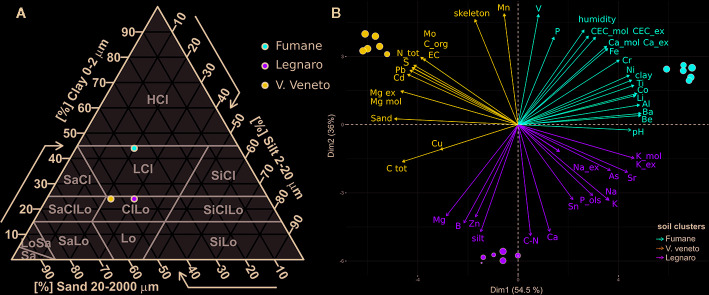

(A) Texture triangle according to the IUSS (International Union of Soil Science). Soils were classified based on the percentages of sand, silt, and clay. CiLO, clay loam; HCl, heavy clay. (B) Principal component analysis (PCA) and biplot between PC1 (Dim1) and PC2 (Dim2) showing the contribution of 48 physico-chemical parameters (including microelements, macroelements, and exchangeable cations) in explaining the variability of the graphical disposition of the three soils under study. Each colored point represents a soil replicate (n = 6). Red points refer to Fumane soil (F), blue points to Vittorio Veneto (VV), and green points indicate Legnaro soils (L).